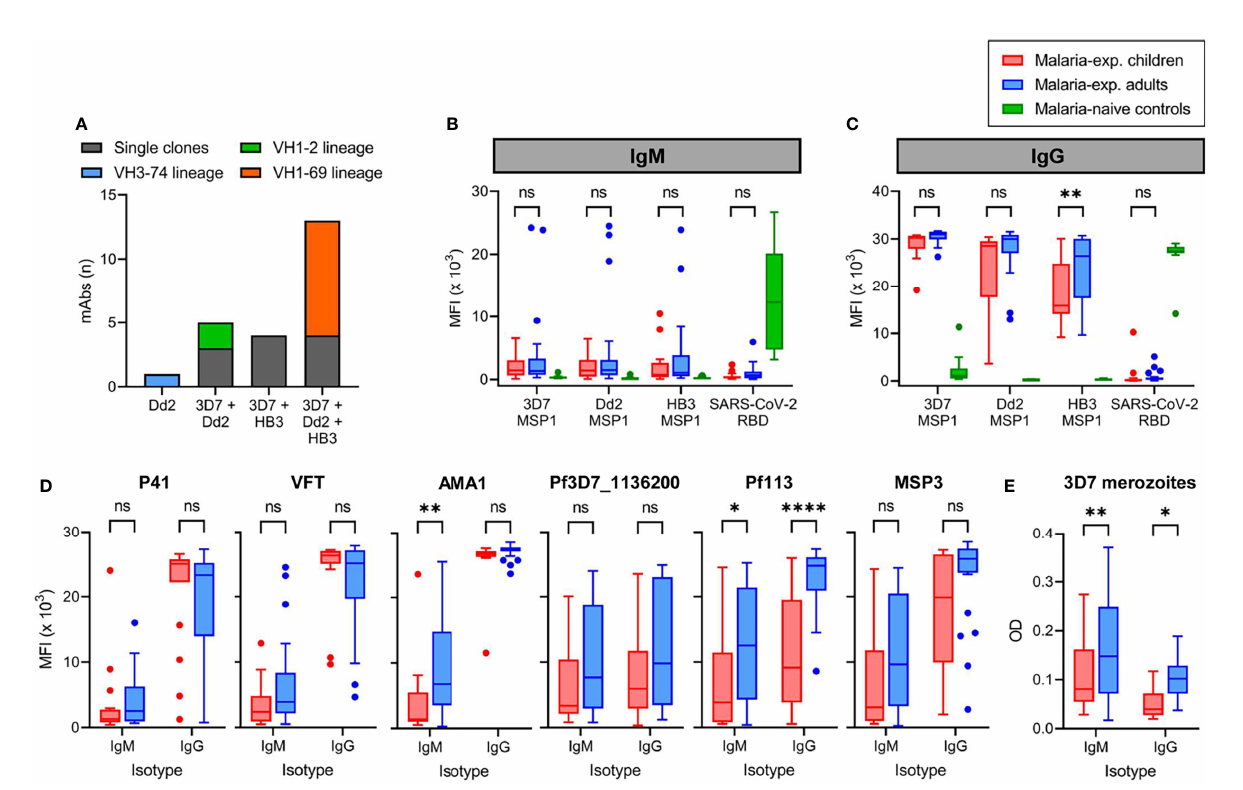
FIGURE 5 | Reactivity of monoclonal antibodies and plasma IgM and IgG against different strains of P. falciparum. (A) The number of anti-PfMSP1 recombinant monoclonal antibodies (mAbs) with reactivity against recombinant full-length PfMSP1 of three different P. falciparum strains in a Luminex assay. Each mAb is color-coded based on whether it was a single clone or derived from an expanded clonal B cell lineages. The VH3-74 lineage consisted of two MBCs, of which we were unable to retrieve the light chain for the second mAb. For this reason, only a single mAb of this lineage was tested here. (B, C) Reactivity of plasma IgM (B) and IgG (C) from malaria- experienced children (n = 18) and adults (n = 24), and malaria-naïve recovered US COVID-19 patients (control; n = 10) against recombinant full-length PfMSP1 of P. falciparum strains 3D7, Dd2, and HB3, as well as SARS-CoV-2 receptor binding domain (RBD), as determined by Luminex assay. Values shown are mean fl uorescence intensity (MFI). (D) Reactivity of plasma IgM and IgG from malaria-experienced children (n = 18) and adults (n = 24) against recombinant P. falciparum 3D7 P41, VFT, AMA1, Pf3D7_1136200, Pf113, and MSP3. (E) Reactivity of plasma IgM and IgG from malaria-experienced children (n = 18) and adults (n = 24) against whole merozoites by ELISA. Values shown are optical densities after subtraction of background values obtained using pooled unexposed plasma from US donors. Data shown in panels (B – D) were tested for statistical signi fi cance using a two-way repeated measures ANOVA, followed by comparisons between children and adults using S ̌ ı ́ da ́ k ’ s post-hoc test, corrected for multiple comparisons. ****P < 0.0001; **P < 0.01; *P < 0.05; ns, not signi fi